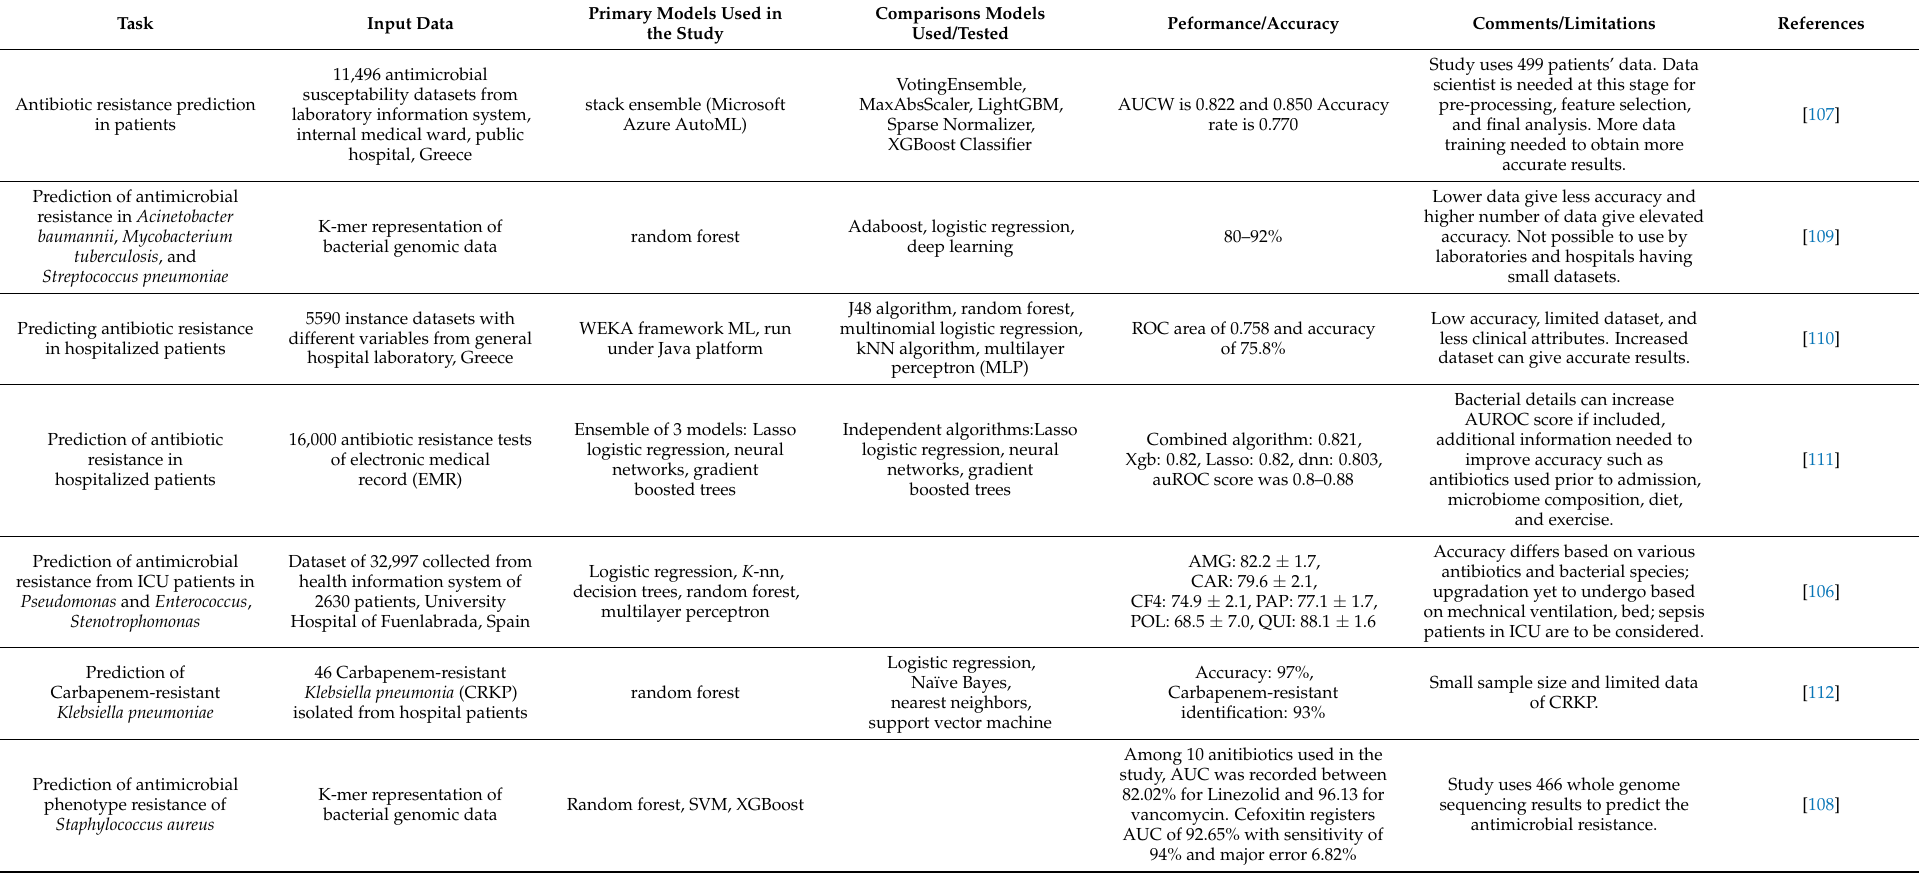
Table 1. Summary of studies using machine language for prediction of antibiotic resistance for clinical